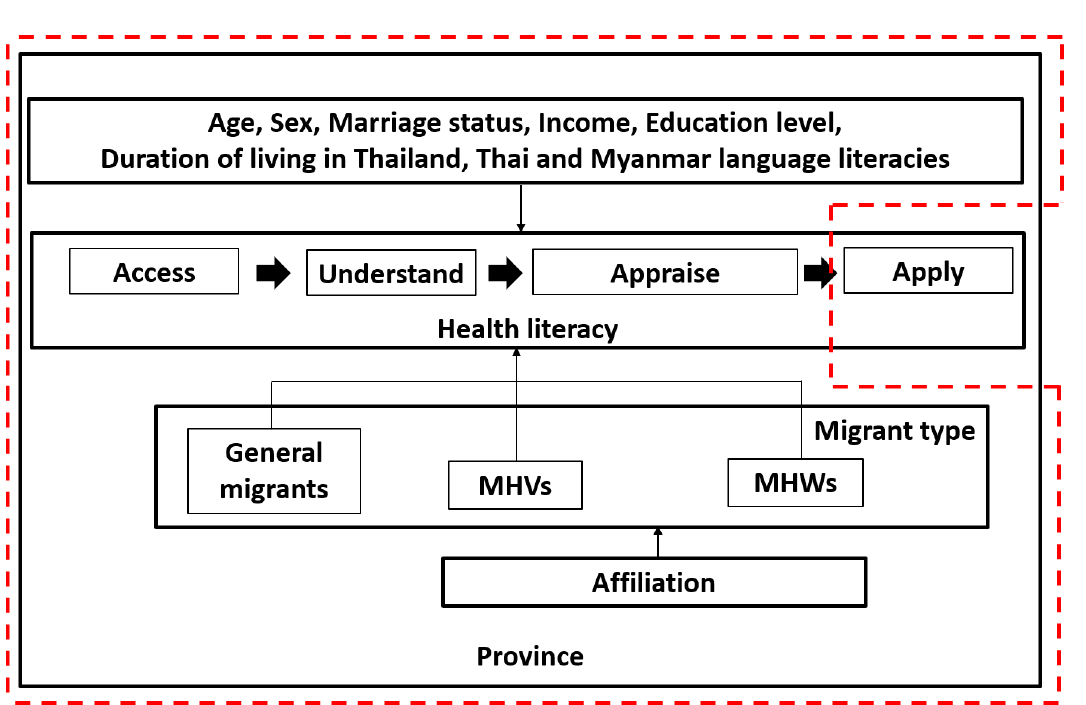
Figure 1. Conceptual Framework of associated factors with health literacy. Red line is the scope of this this study.